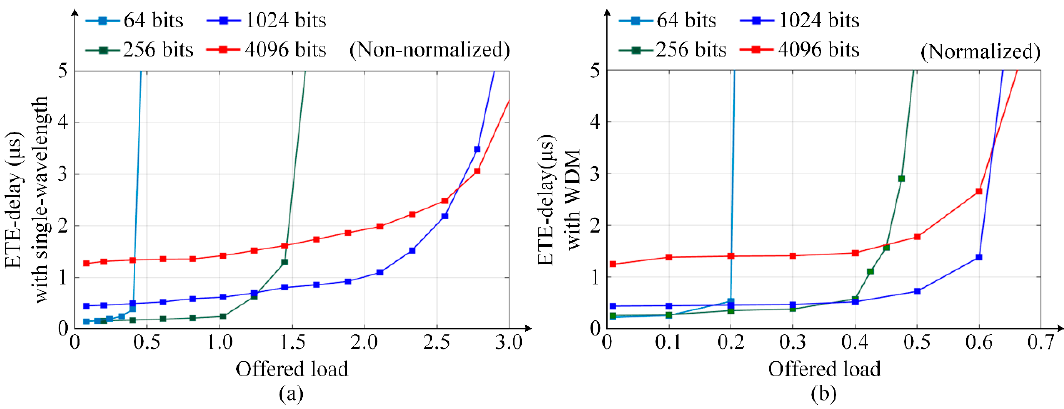
Figure 15. Network ETE delay and throughput comparison of torus-based ONoCs with single wavelength and WDM technology at data rate 40 Gbps.